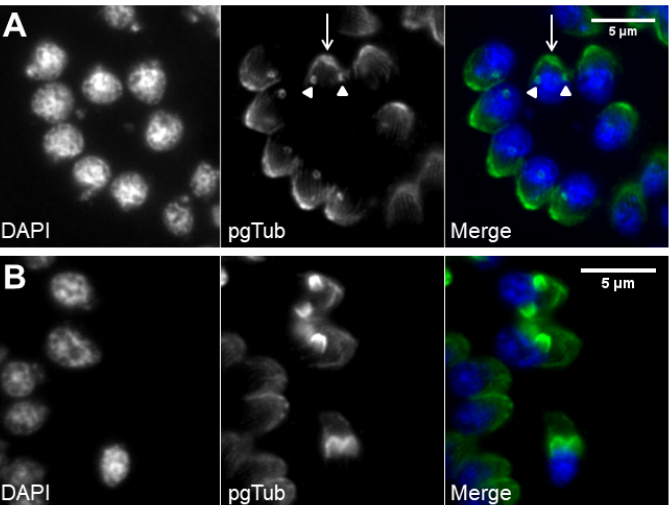
Figure 4. De novo formation of the cytoskeleton drives daughter cell assembly. Immunofluorescence of intracellular tachyzoites in which the apical cytoskeleton is identified by polyglutamylated tubulin (pgTub) and DNA is stained with DAPI. ( A ) Rosette with eight tachyzoites with the apical cytoskeleton identified, namely, the conoid and attached rings (white arrow) and the subpellicular microtubules of the mother cells, as well as the conoids of the forming daughter cells (white arrowheads). ( B ) Three tachyzoites in the center show the forming daughter cell’s apical cytoskeleton advancing towards the basal pole. The scale bars represent 5 µm.